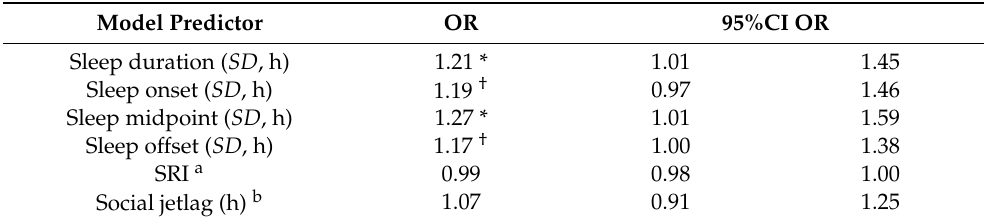
Table 2. Between-person associations of sleep variability per youth across monitoring days with average odds of caffeinated beverage consumption ( n =